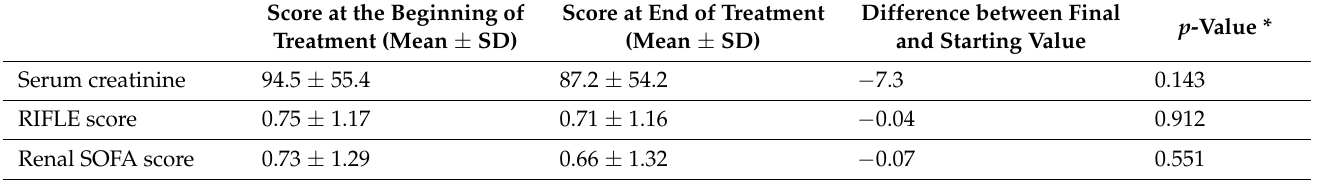
Table 4. Development of AKI during ganciclovir treatment, determined by the difference in RI- FLE score, renal SOFA score, and serum creatinine, between the first and last day of treatment with ganciclovir.